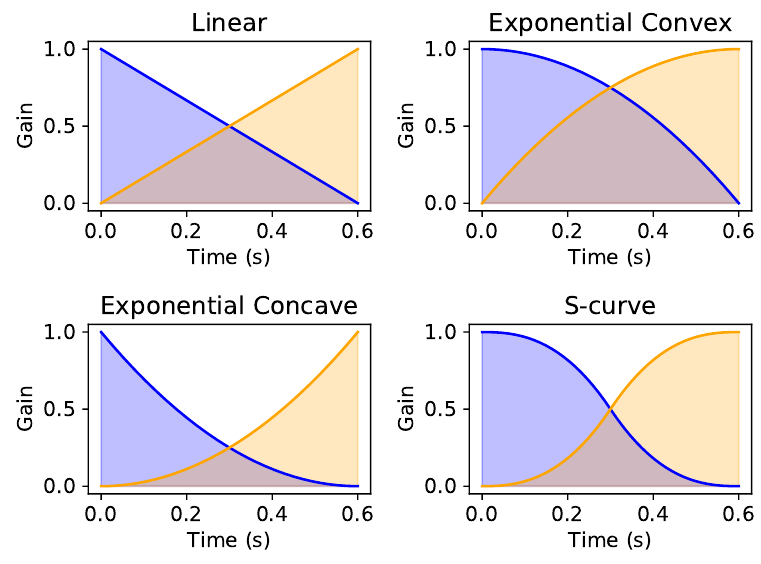
Figure 3. The four types of fade curves present in audio